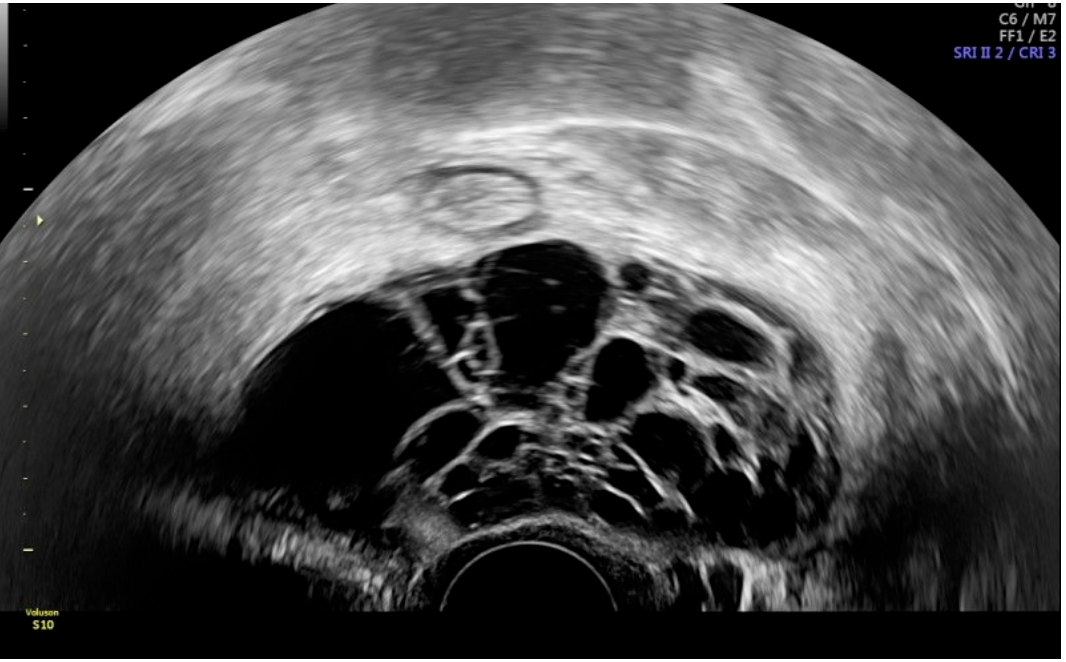
Figure 25. Transvaginal ultrasound shows a pelvic multilocular solid lesion independent from both ovaries in a patient with previous cystic lymphangioma.